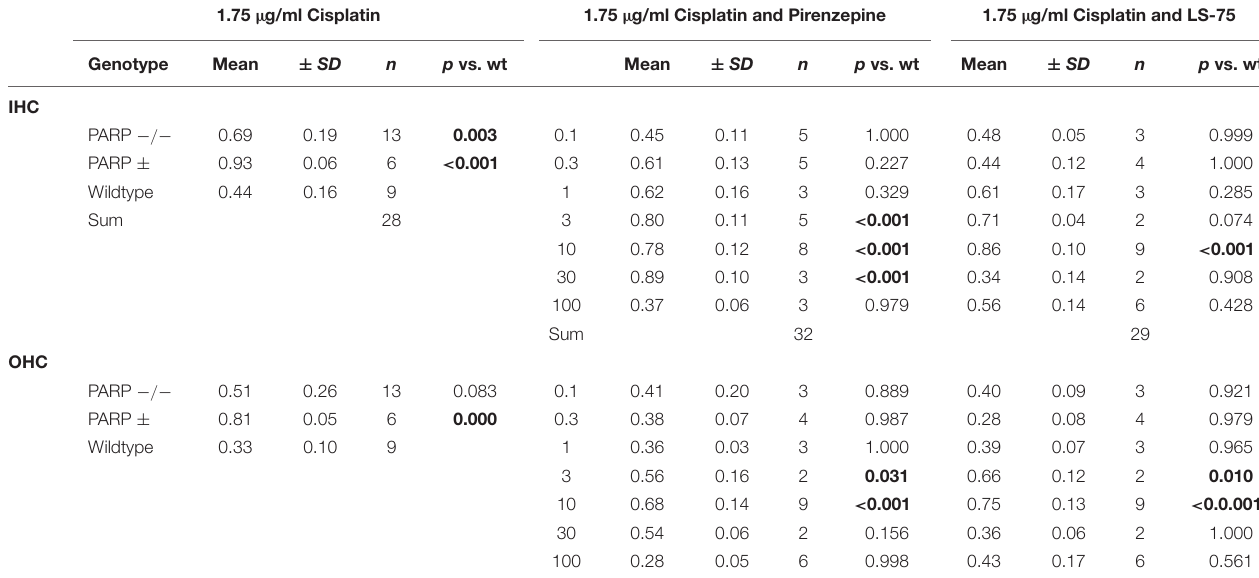
TABLE 2 | Mean cochlear perservation (arithmetic mean, fraction) at 1.75 µ g/ml cisplatin combined with Pirenzepin or LS-75 at various concentrations.